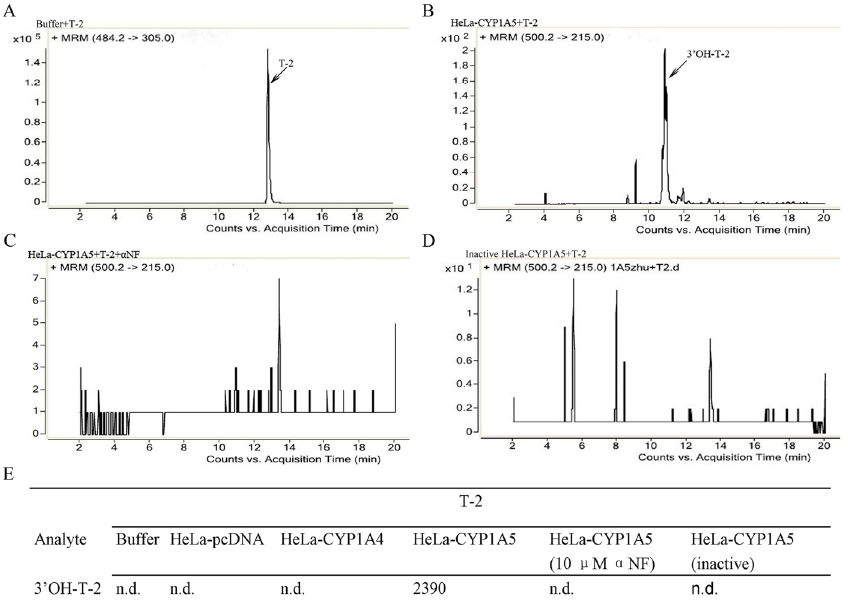
Figure 3. LC-ESI-MS/MS analysis of T-2 and its metabolites formed in HeLa transformants expressing CYP1A4 and CYP1A5. The detection was accomplished by MRM with the transitions m / z 484.2/305.0 for T-2 and m / z 500.2/215.0 for 3'-hydroxy-T-2. The data